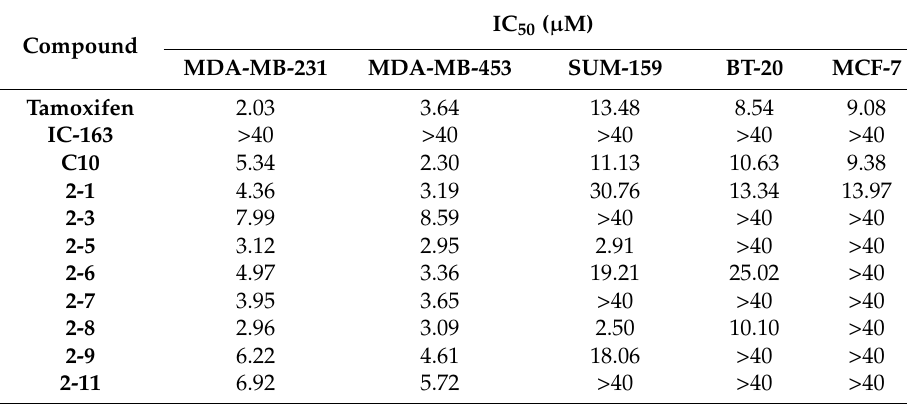
Table 2. Activities of eight analogs of C10 measured on different cell lines.